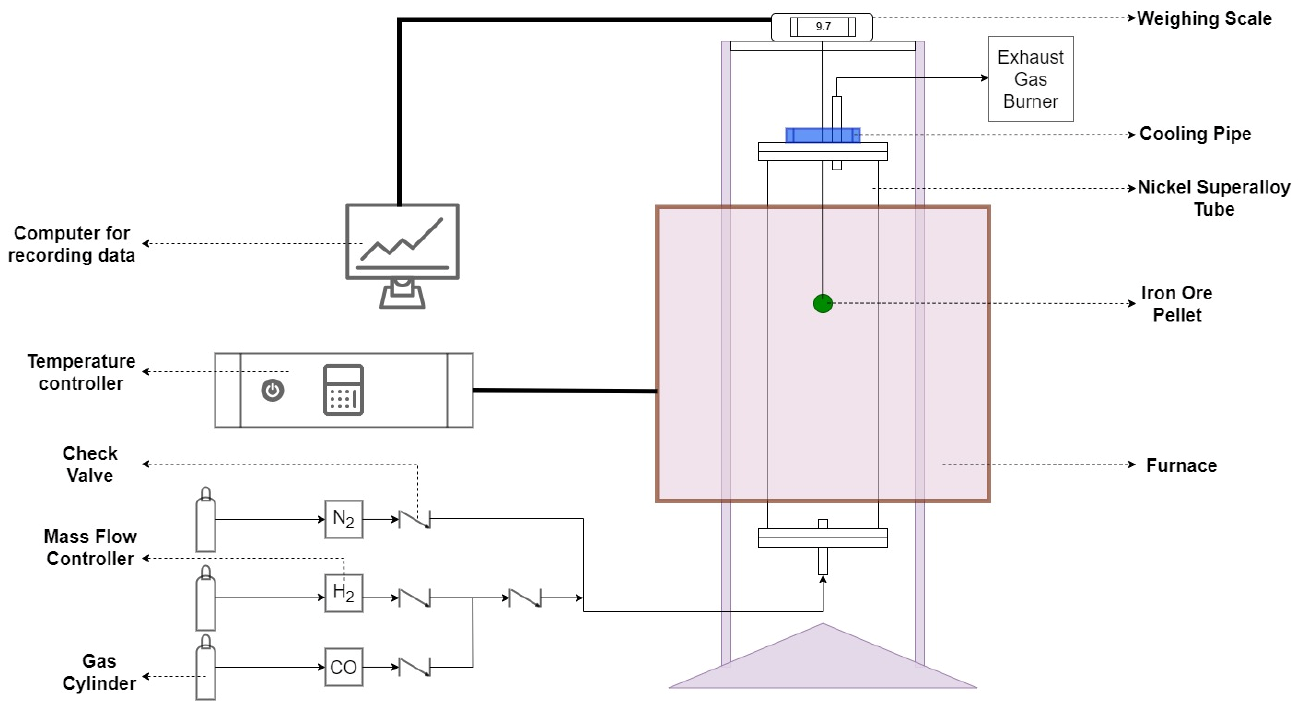
Figure 1. Pellet size distribution of 251 randomly selected pellets.